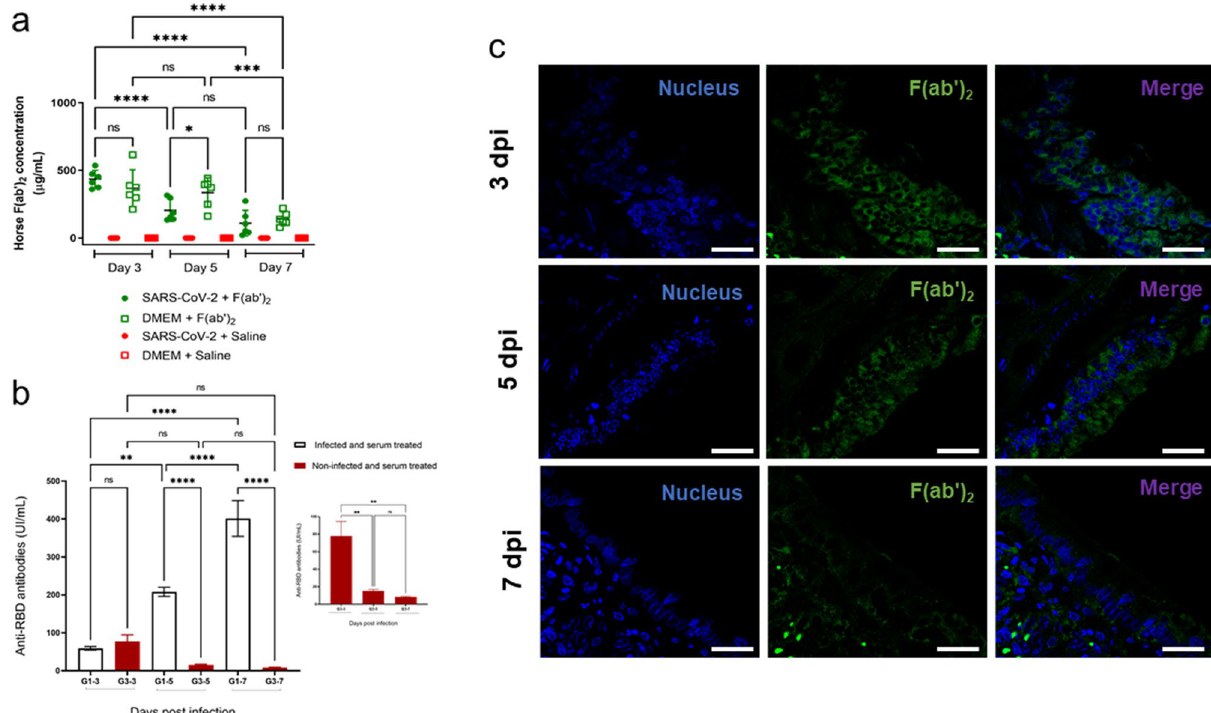
Figure 6. Detection of antibodies in the Golden Syrian hamster COVID model. ( a ) ELISA plates were coated with 100 µL of rabbit anti-horse IgG and then incubated with a previously prepared standard curve consisting of known concentrations of anti-SARS-CoV-2 horse F(ab ′ ) 2 parallel to hamster serum samples. Horse F(ab ′ ) 2 in the standard curve or in the samples was then detected by adding peroxidase-conjugated anti-horse IgG followed by the TMB substrate. Absorbance values were measured at 450 nm. The standard curve was linearized by log–log transformation and then subjected to linear regression analysis. The concentration of horse F(ab ′ ) 2 in hamster serum samples was estimated by interpolating the samples to the standard curve. ( b ) The cPass™ kit for SARS-CoV-2 neutralizing antibody detection was used according to the manufacturer’s instructions for qualitative direct detection of total neutralizing antibodies to SARS-CoV-2 in hamster sera. ( c ) Positive immunofluorescence for F(ab ′ ) 2 in the lungs of the noninfected group. Thin lung tissue sections from the noninfected group treated with anti-SARS-CoV-2 equine serum were stained with anti-SARS-CoV-2 spike glycoprotein rabbit antibody for one hour and then washed and treated with an Alexa Fluor 647-conjugated anti-rabbit antibody for 30 min. After washing, anti-horse IgG FITC was added, incubated for one hour and washed, and the slides were mounted using Hoechst. The sections were visualized under a confocal microscope (Leica TSC SP8 DSL